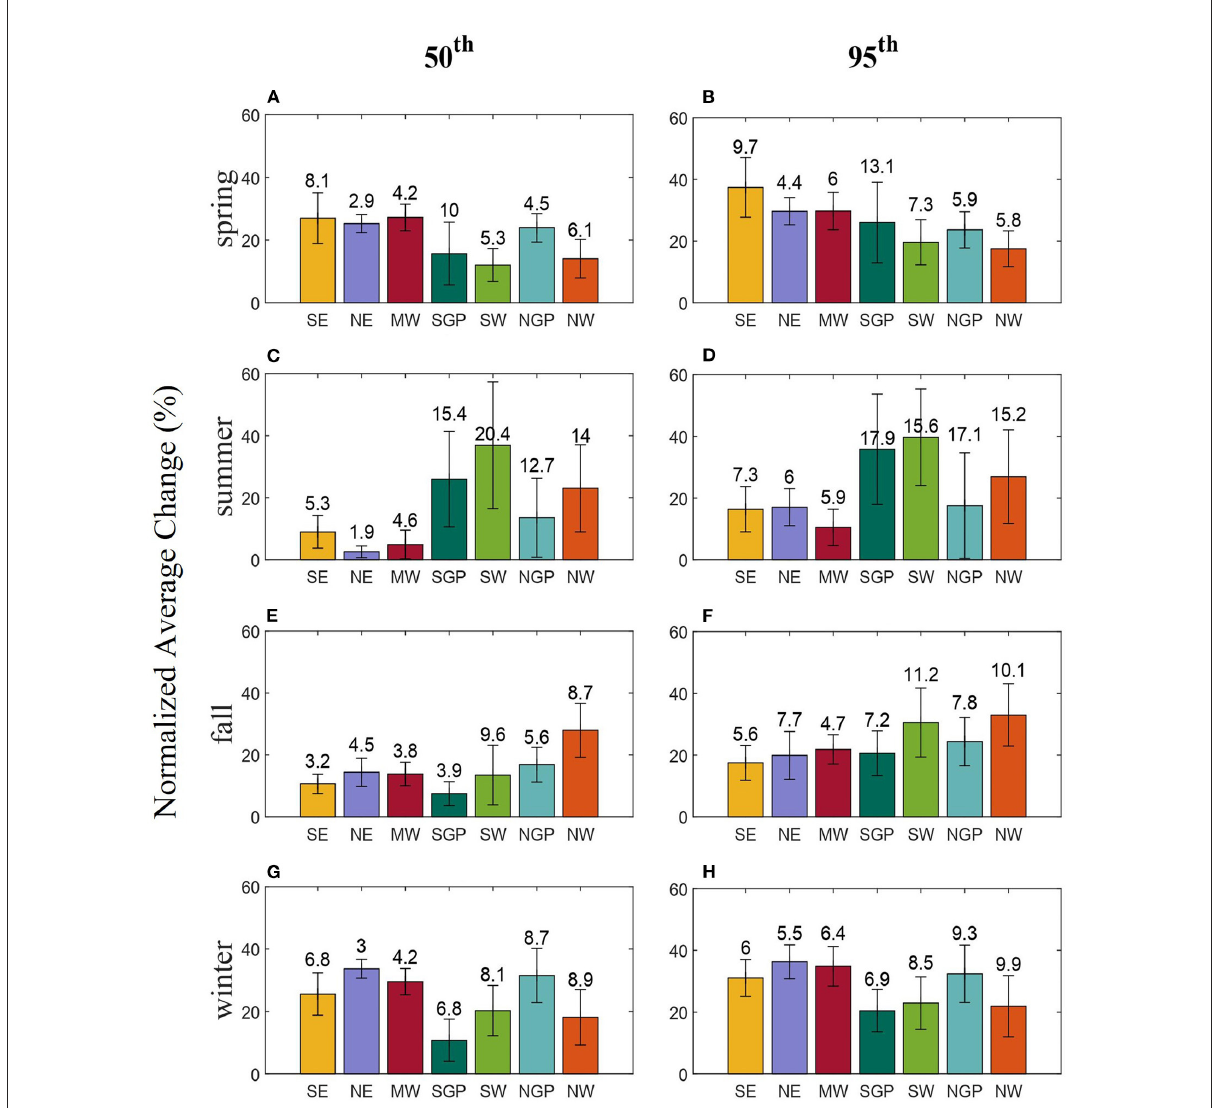
FIGURE5 Normalized regional average change of maximum daily precipitation (mm) represented across seasons for the 50 th and 95 th quantiles compared to historical climatology from 1951 to 2014. Different color bar plots represent the regions of the National Climate Assessment (as shown in Figure 1), and the error bar represents the standard deviation of the normalized change within a region [spring (A) , summer (C) , fall (E) , winter (G) , spring (B) , summer (D) , fall (F) , and winter (H)